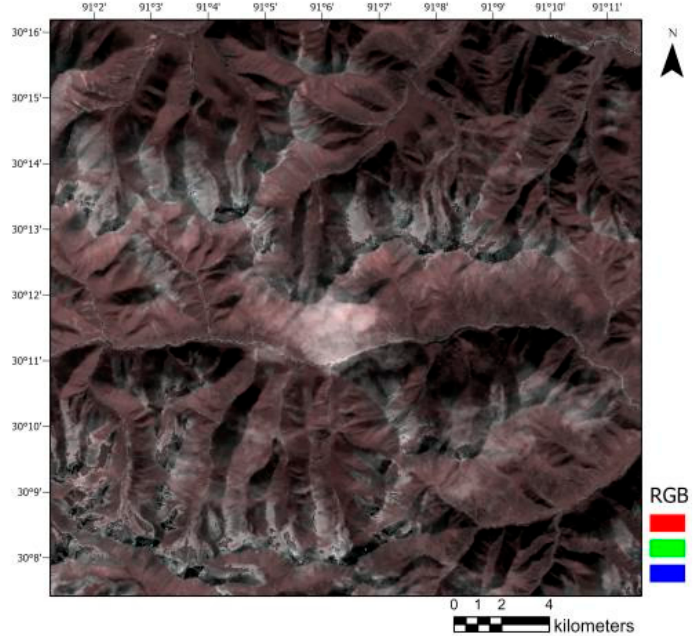
Figure 9. Spectral information in the magnesium hydroxyl-enhanced band.